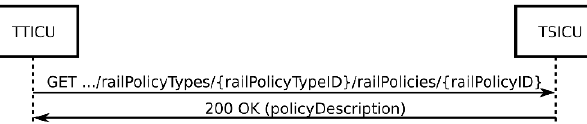
Figure 8. Flow of the rail policy query procedure.